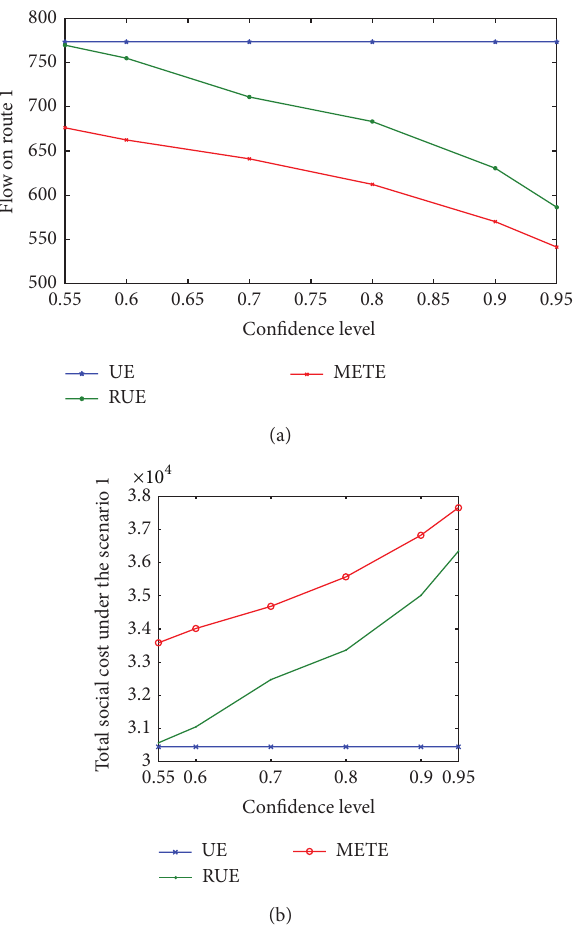
Figure 2: Flow on route 1 and TSC under the scenario 1.